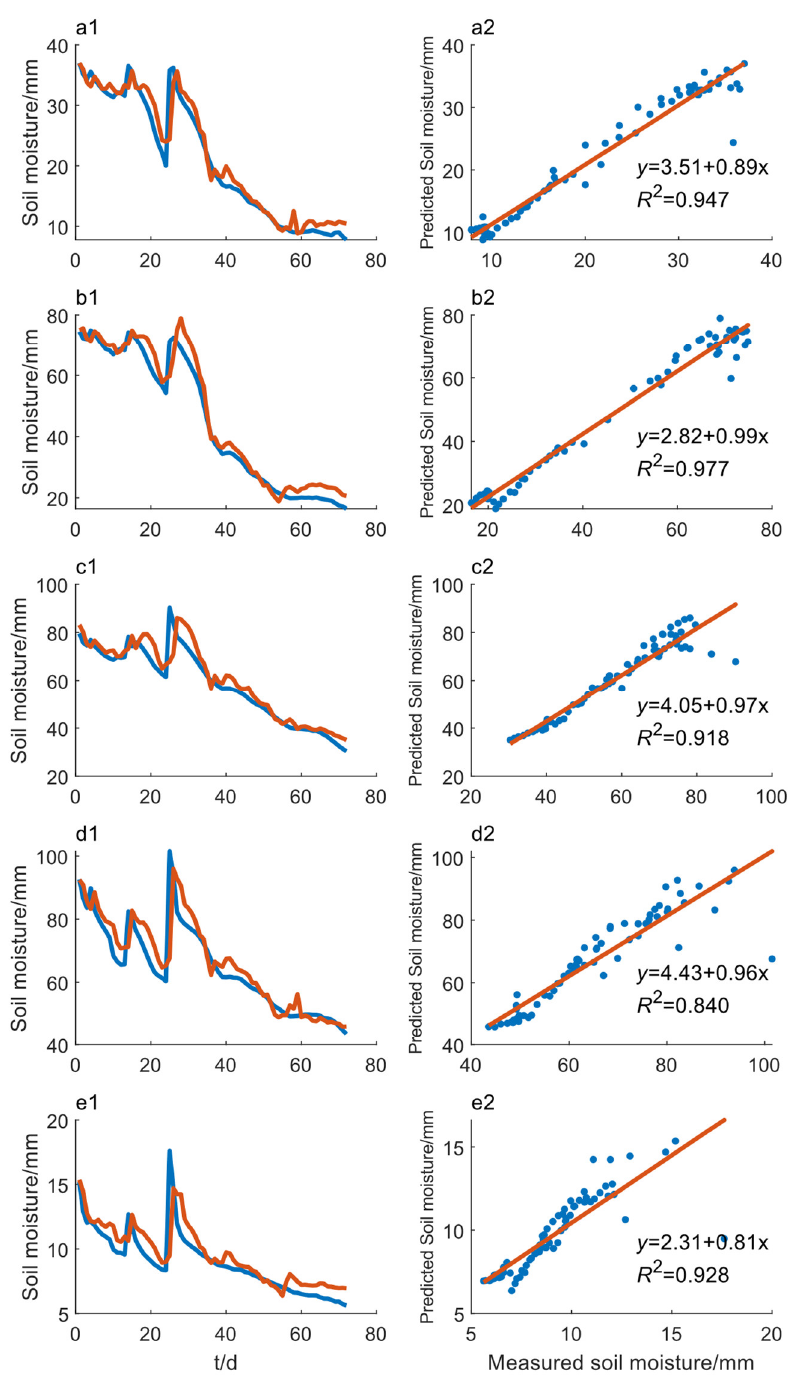
Figure 13. Comparison of the Bid-LSTM model in different datasets for SM. ( a – e ) represent node 1–5, respectively; in ( a1 – e1 ), the blue line represents the measured SM, and the orange line represents the predicted SM; ( a2 – e2 ) represents the regression fitting between the predicted SM and measured SM.